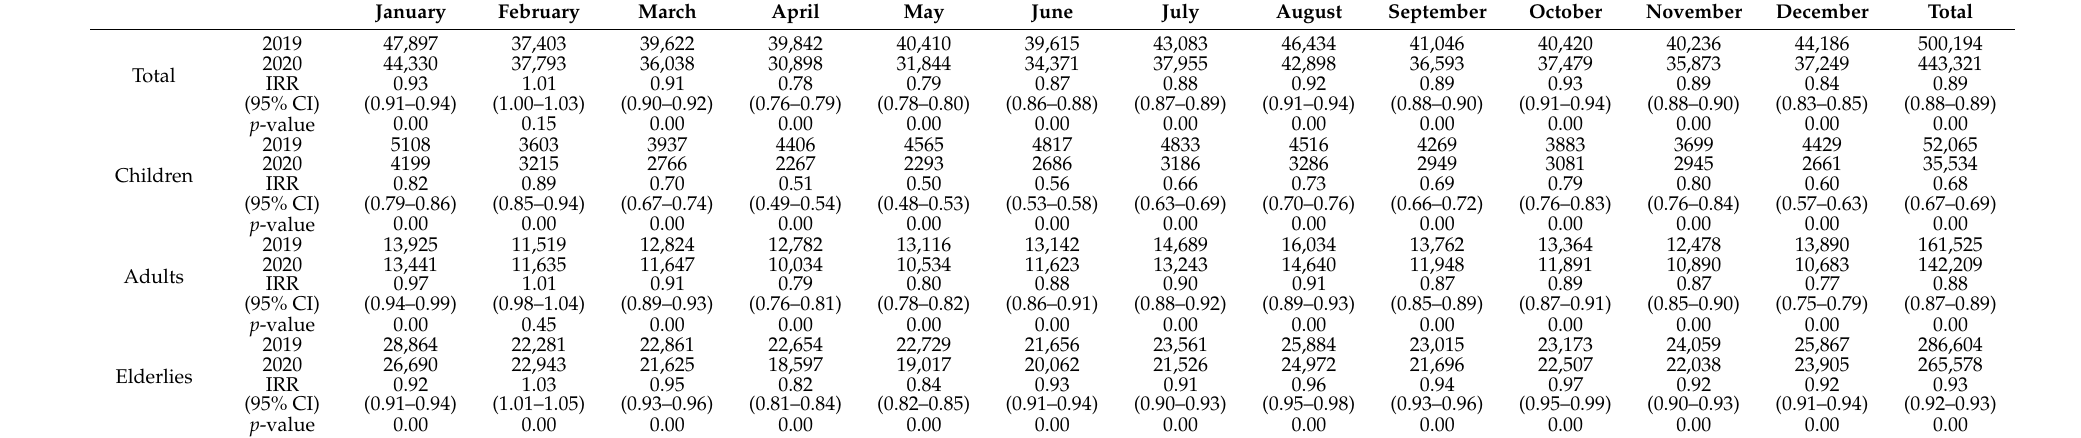
Table 2. The number of emergency patients registered in the Osaka Emergency Information Research Intelligent Operation Network